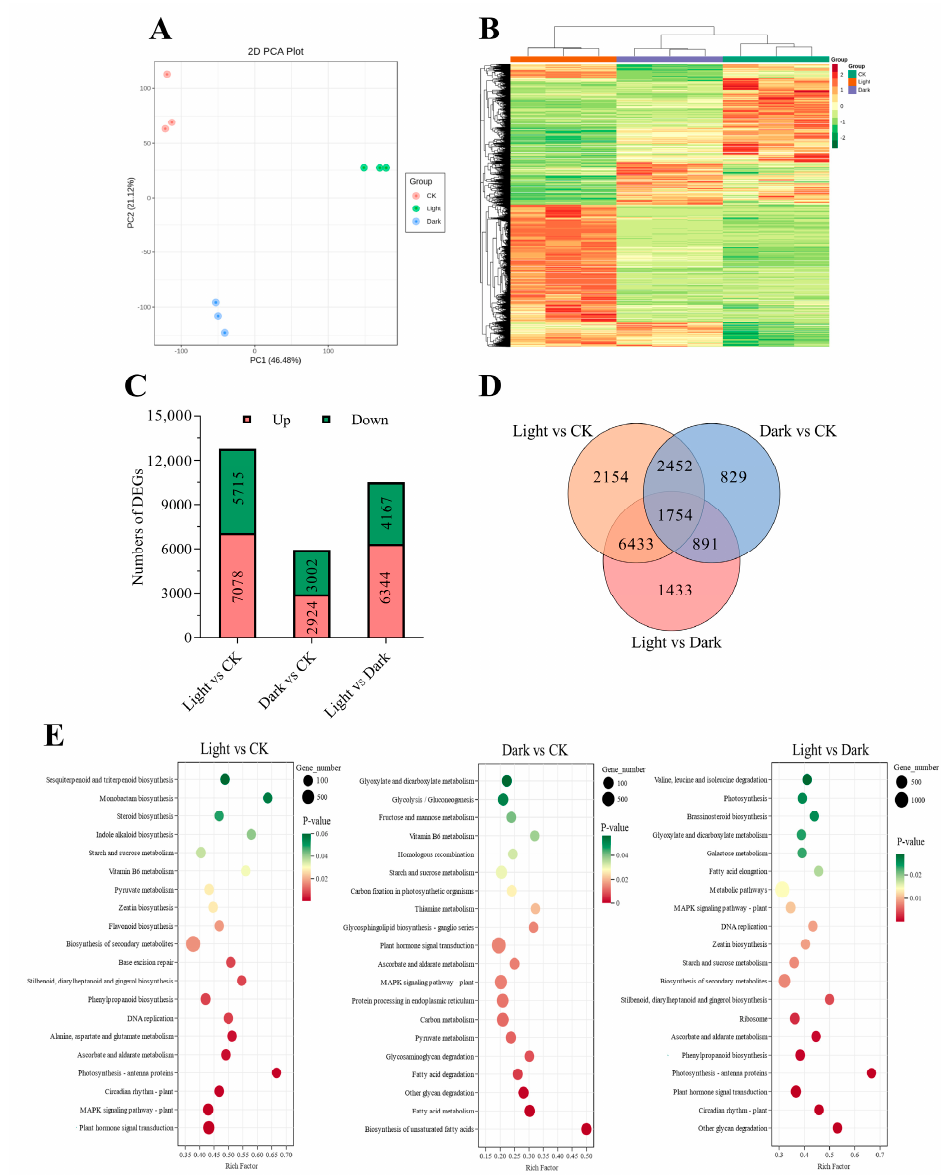
Figure 2. Multivariate statistical analysis of transcriptome data. ( A ) PCA score plot. ( B ) Cluster analysis. The color indicates the relative levels of genes from low (green) to high (red). ( C ) Numbers of genes with differences in relative abundance in different comparison groups. Red and green columns represent the numbers of genes with increases or decreases in relative abundance, respectively. ( D ) Venn diagram showing the overlapping and unique DEGs in the comparison group “Dark/CK”, “Light/CK”, and “Light/Dark”. ( E ) KEGG pathway analysis of DEGs in “Dark/CK”, “Light/CK”, and “Light/Dark”.